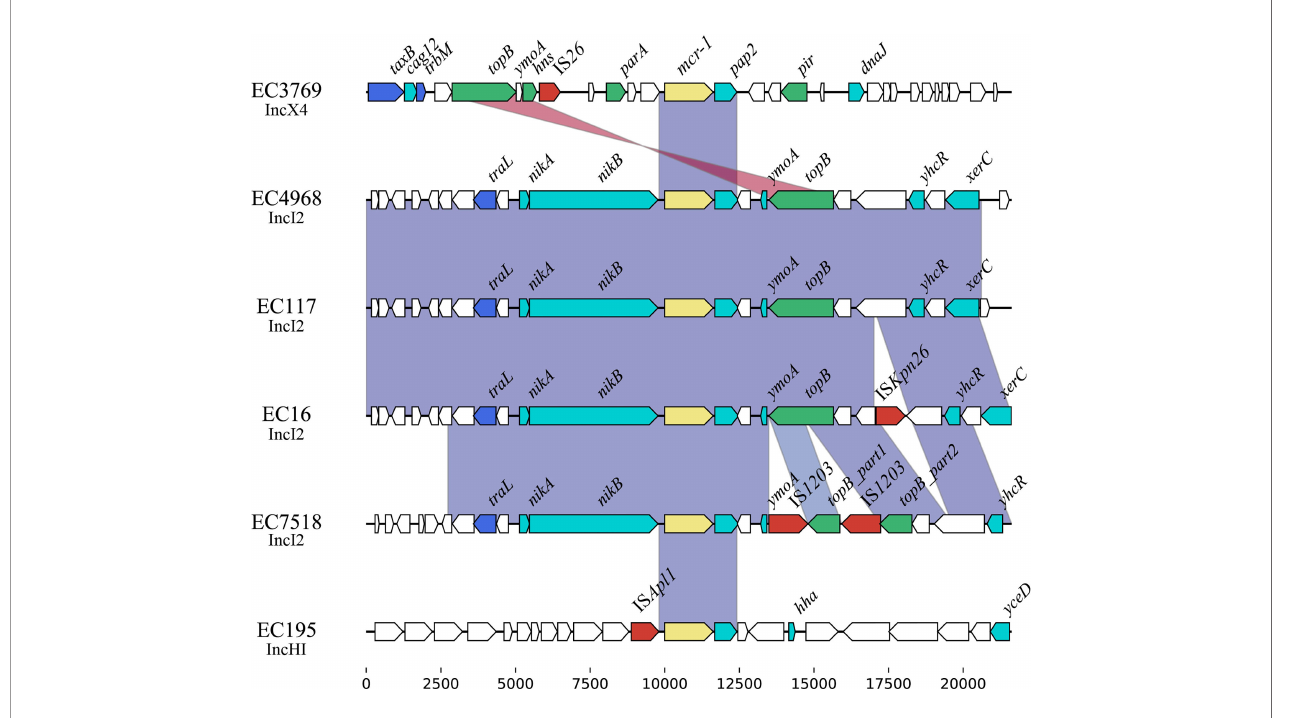
FIGURE 4 | Genetic context of the mcr-1 genes on the sequenced